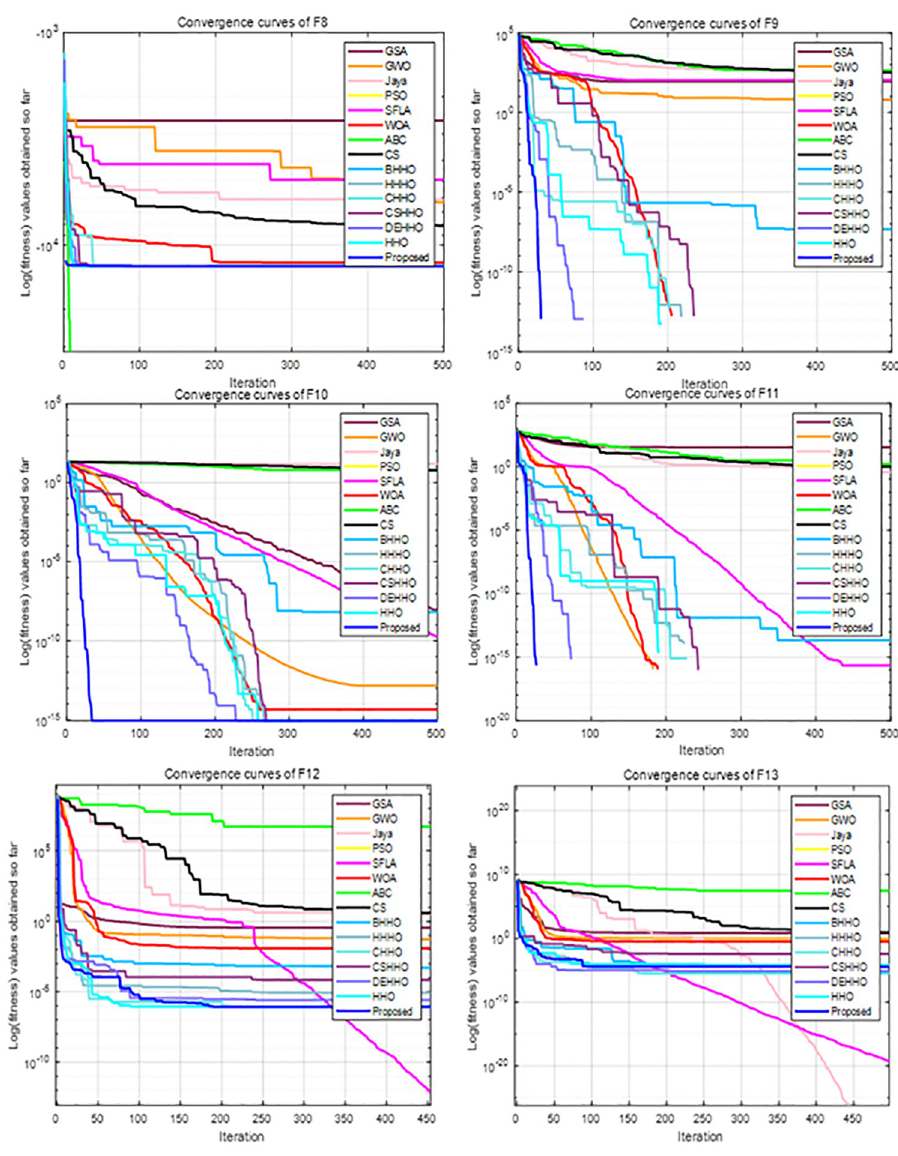
Fig 6. Convergence curves of